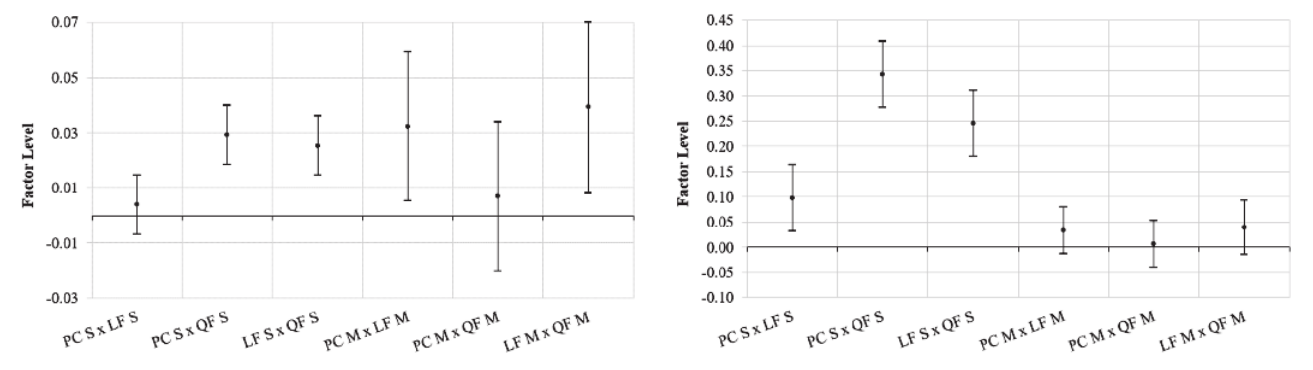
Comparative analysis of the averages, Tukey's test, for 6 weeks of exposure among the series studied, for a significance level of 5% (S-sodium sulfate and M-Magnesium sulfate)